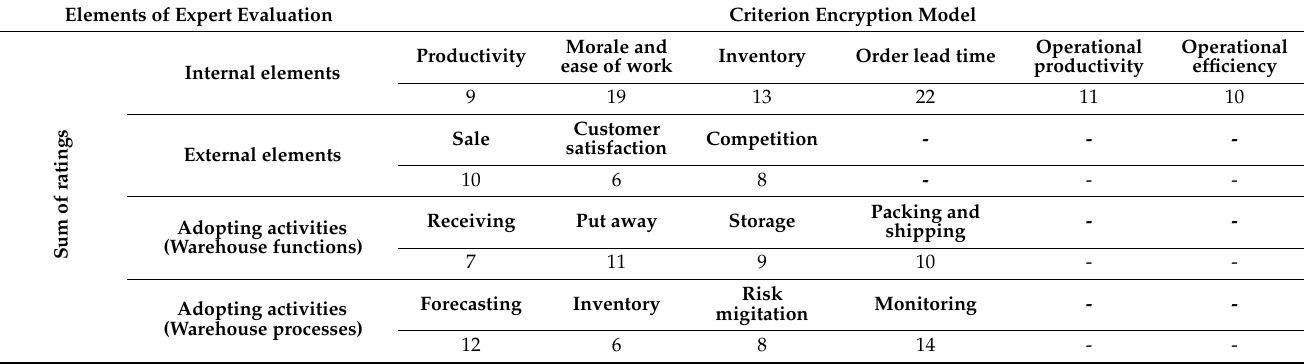
Table 7. The results of the sum of ranks of the expert